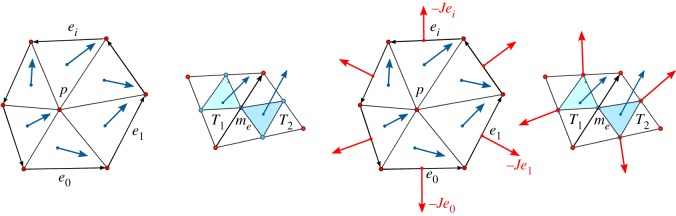
Computation of the curl and divergence of a vector field at a point on ∇Sh and J∇Sh∗.